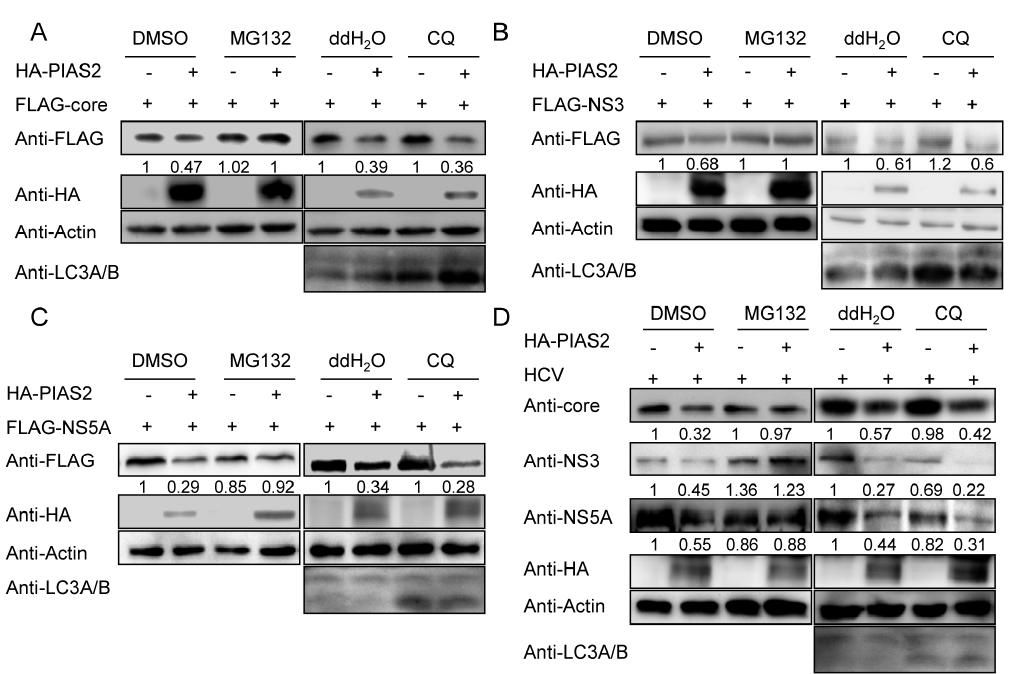
Figure 5. PIAS2 influences the degradation of HCV proteins through the proteasome pathway. ( A – C ) 293T cells were transfected with the indicated HCV protein expression plasmid, pCer-SUMO1 and pHA-Vector or pHA-PIAS2 and incubated for 48 h. Then, the cells were treated with MG-132 or chloroquine (CQ) for 4 h, and the protein expression levels were detected by western blotting; ( D ) Huh7 cells were transfected with either pHA-Vector or pHA-PIAS2 and infected with J399EM at an MOI of 0.1 for 72 h. After 4 h MG132 or chloroquine treatment, the expression levels of the HCV proteins were evaluated. The numbers below each blot show the relative density of the blots normalized to actin. DMSO: dimethyl sulfoxide.